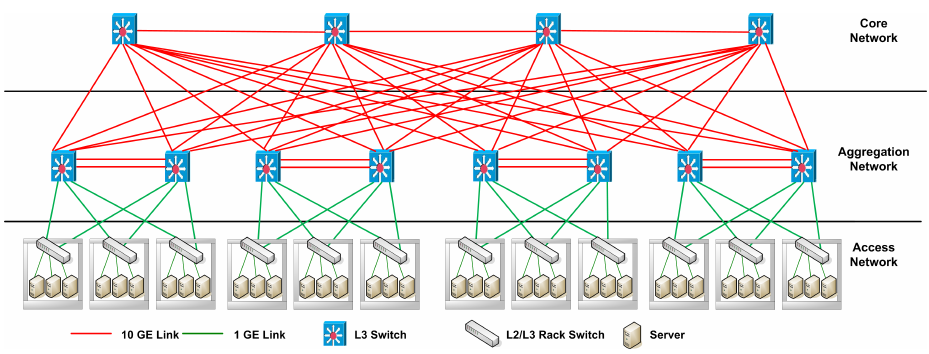
Figure 1. EAFT Architecture with one level of fault